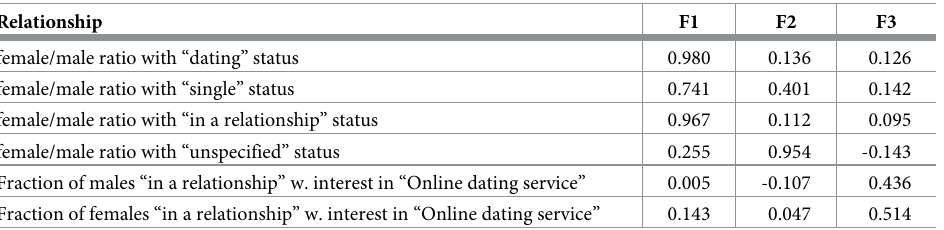
Table 2. Factor analysis of the Facebook relationship related